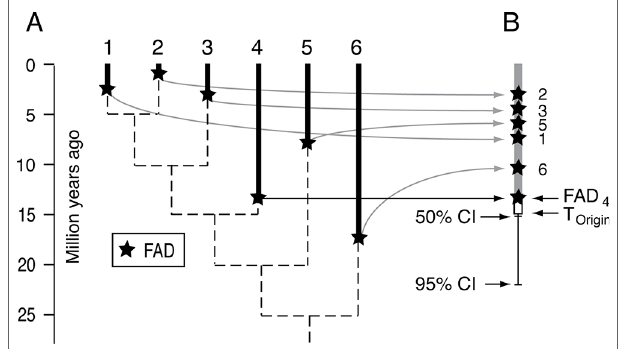
FIGURE 7 | Schematic for the super-taxon approach for using multiple FAD s to constrain the time of origin of a clade. (A) Hypothetical ultrametric tree (dashed lines) with the FAD s for each lineage. (B) The method uses the branch lengths of the ultrametric tree to map the FAD s onto a single lineage, or super- taxon, and then uses confidence intervals (equation [1]) to bracket the time of origin, that is estimate the size of ΔT Gap for the entire clade. See Marshall (2008) for further explanation. Adapted from Figure 1 in Marshall